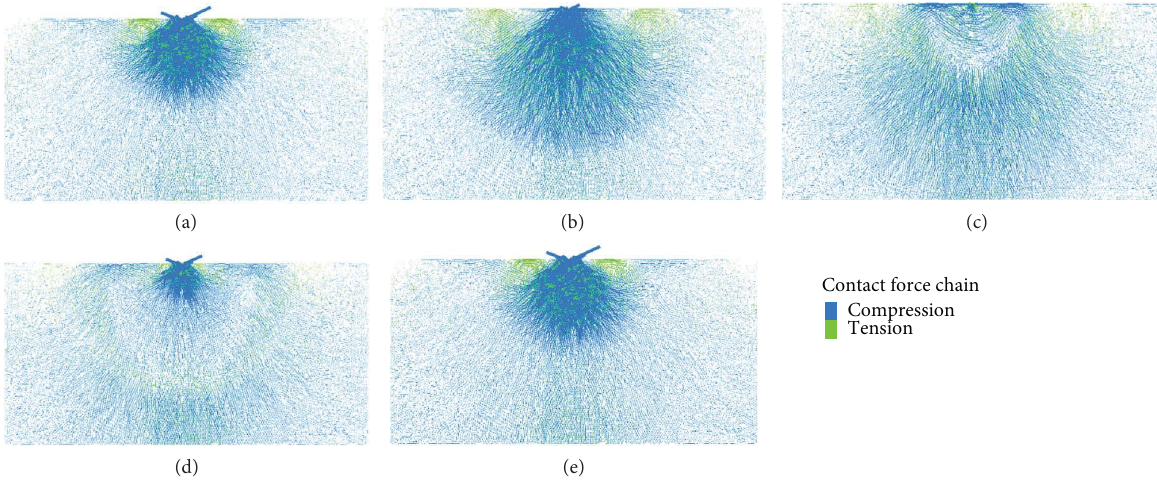
Figure 6: Distribution of the contact force chain: (a)—(e) change in the force chain in one period.